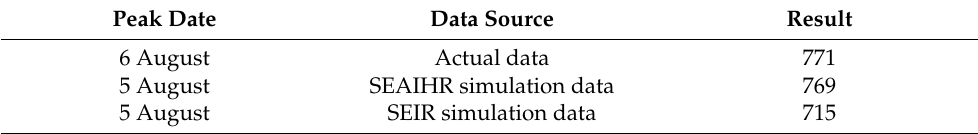
Table 10. Peak value